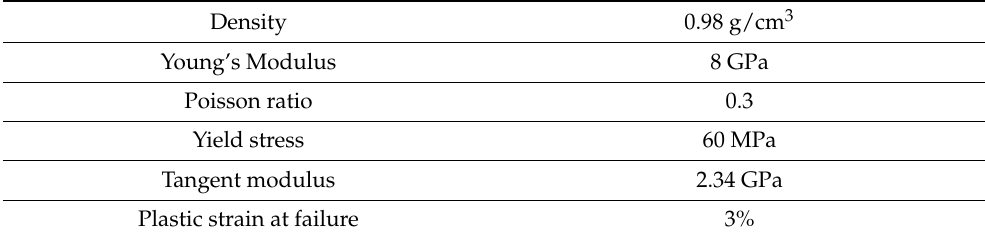
Table 2. Material characteristics of Epoxy-862.